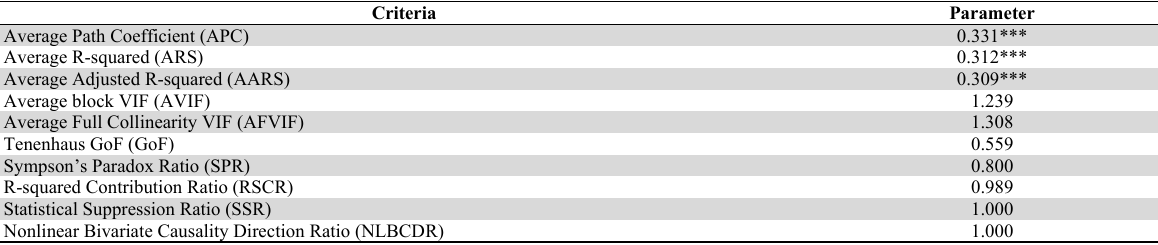
Goodness of Fit Research